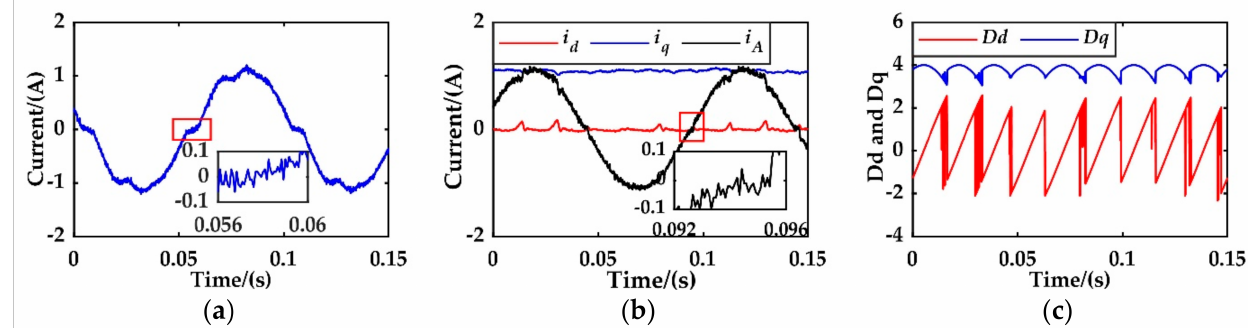
Figure 3. Waveforms of phase A current, Dd and Dq at 150 r/min. ( a ) Phase A current without compensation. ( b ) Phase A current and dq –axis currents after compensation with conventional DM–CZD. ( c ) Dd and Dq after compensation with conventional DM-CZD.